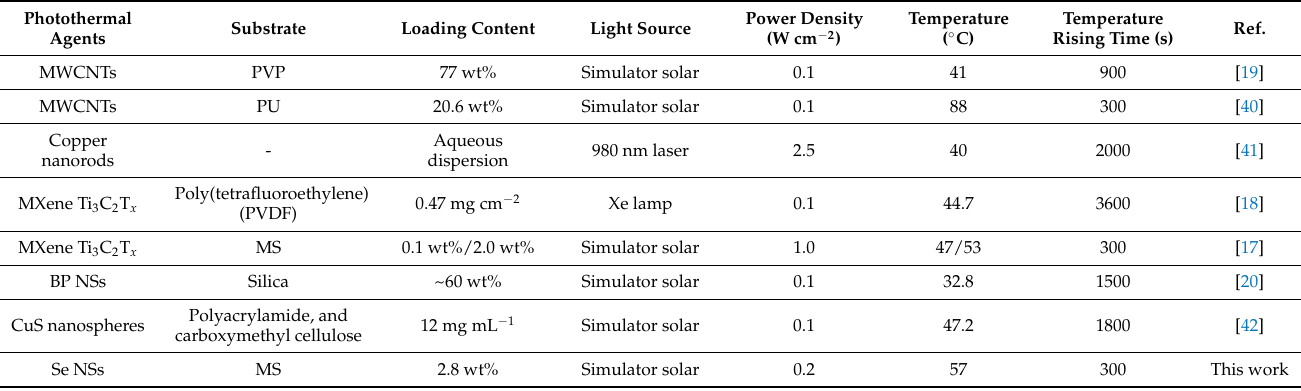
Table 1. Photothermal performance comparison of the recently reported materials.